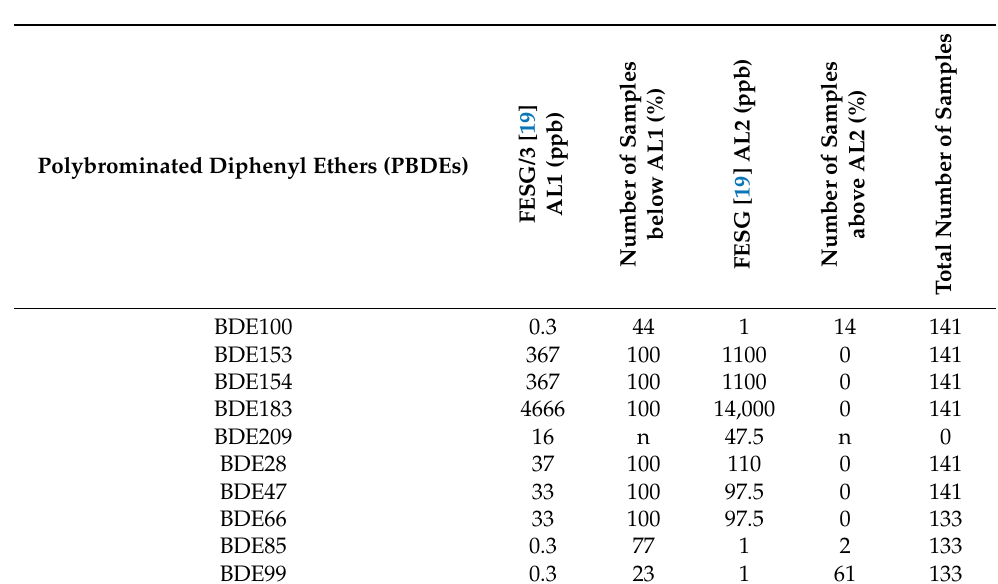
Table 19. Polybrominated diphenyl ether flame retardants (PBDEs)—Individual BDEs—FESG Per- centage of samples below AL1 (FESG/3); above AL2 (FESG). n–No data available for BDE209. No FESG for BDE138 or